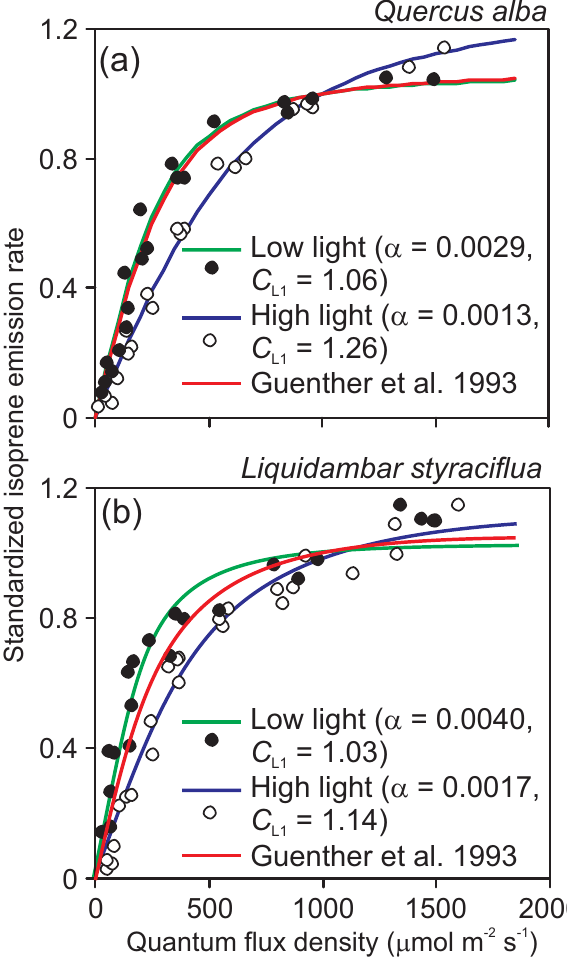
Fig. 1. The rate of isoprene emission in relation to incident quan- tum flux density (light intensity, Q ) in temperate broad-leaved de- ciduous species Quercus alba (a) (data modified from Harley et al., 1997) and Liquidambar styraciflua (b) (data modified from Harley et al., 1996) studied in leaves from the lower and upper canopy. The emission rate was standardized with respect to the rate measured at Q of 1000µmolm − 2 s − 1 that is the typical light intensity at which the isoprenoid emission potential, E S , is defined (Guenther et al., 1993). The light response function (Eq. 2) was fitted to the data and the model parameters, α , the apparent quantum yield, and C L1 , the scaling coefficient, are shown for the different responses. In ad- dition, the original light-response function reported by Guenther et al. (1993) is shown in both panels (red